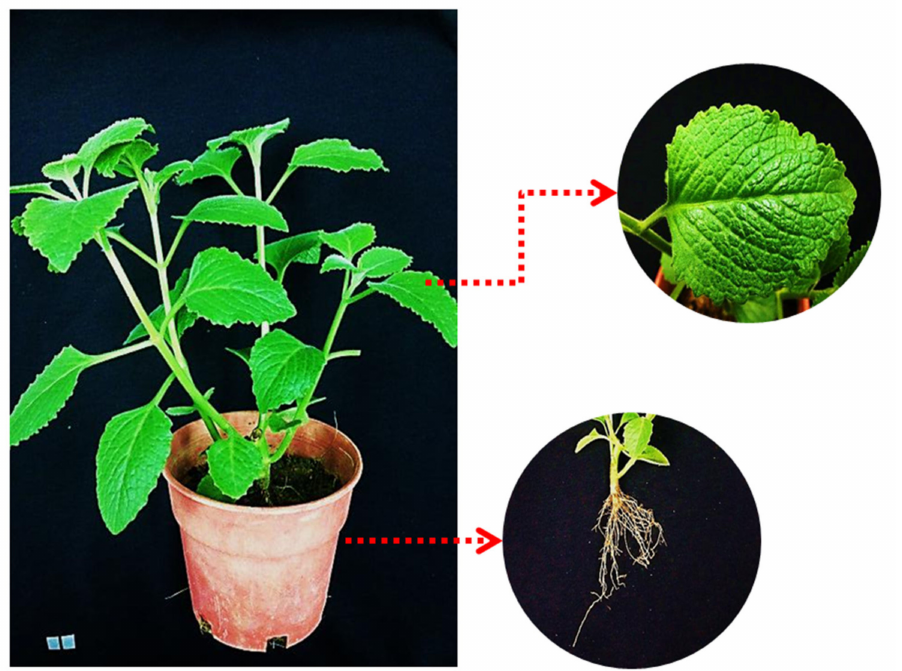
Figure 1. Plectranthus